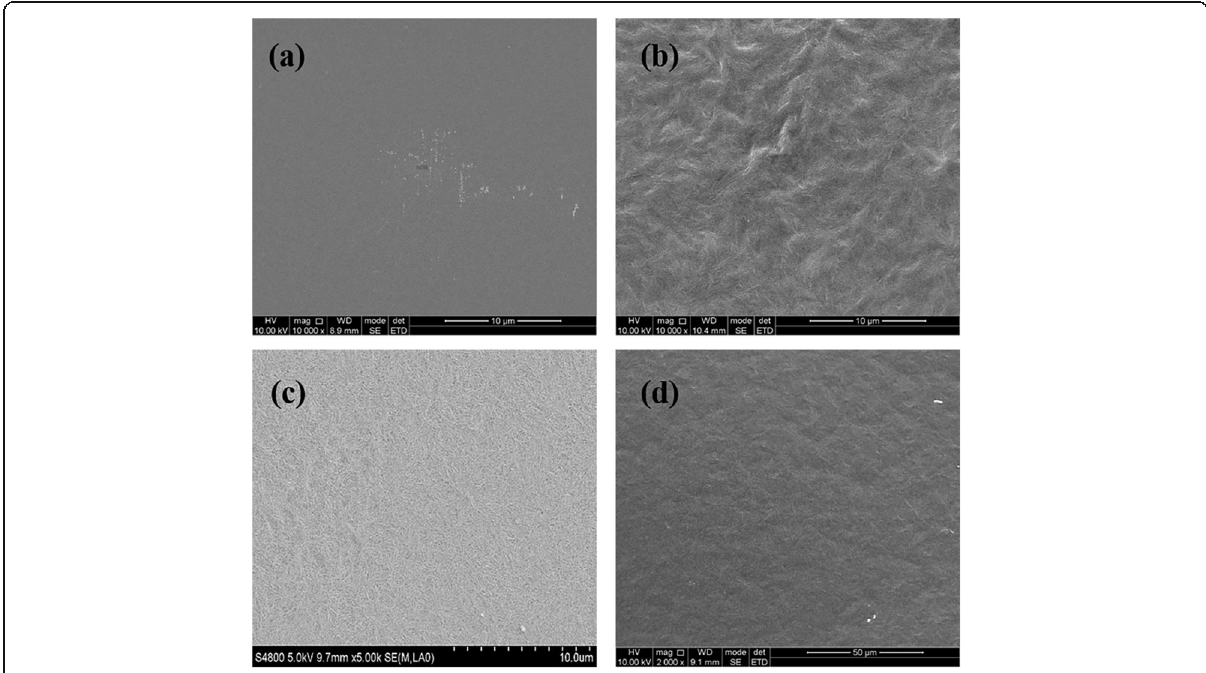
Fig. 4 SEM image of different films. a ArPTU. b PVDF-TrFE-CFE/ArPTU (90/10). c PVDF-TrFE-CFE. d PVDF-TrFE-CFE/ArPTU